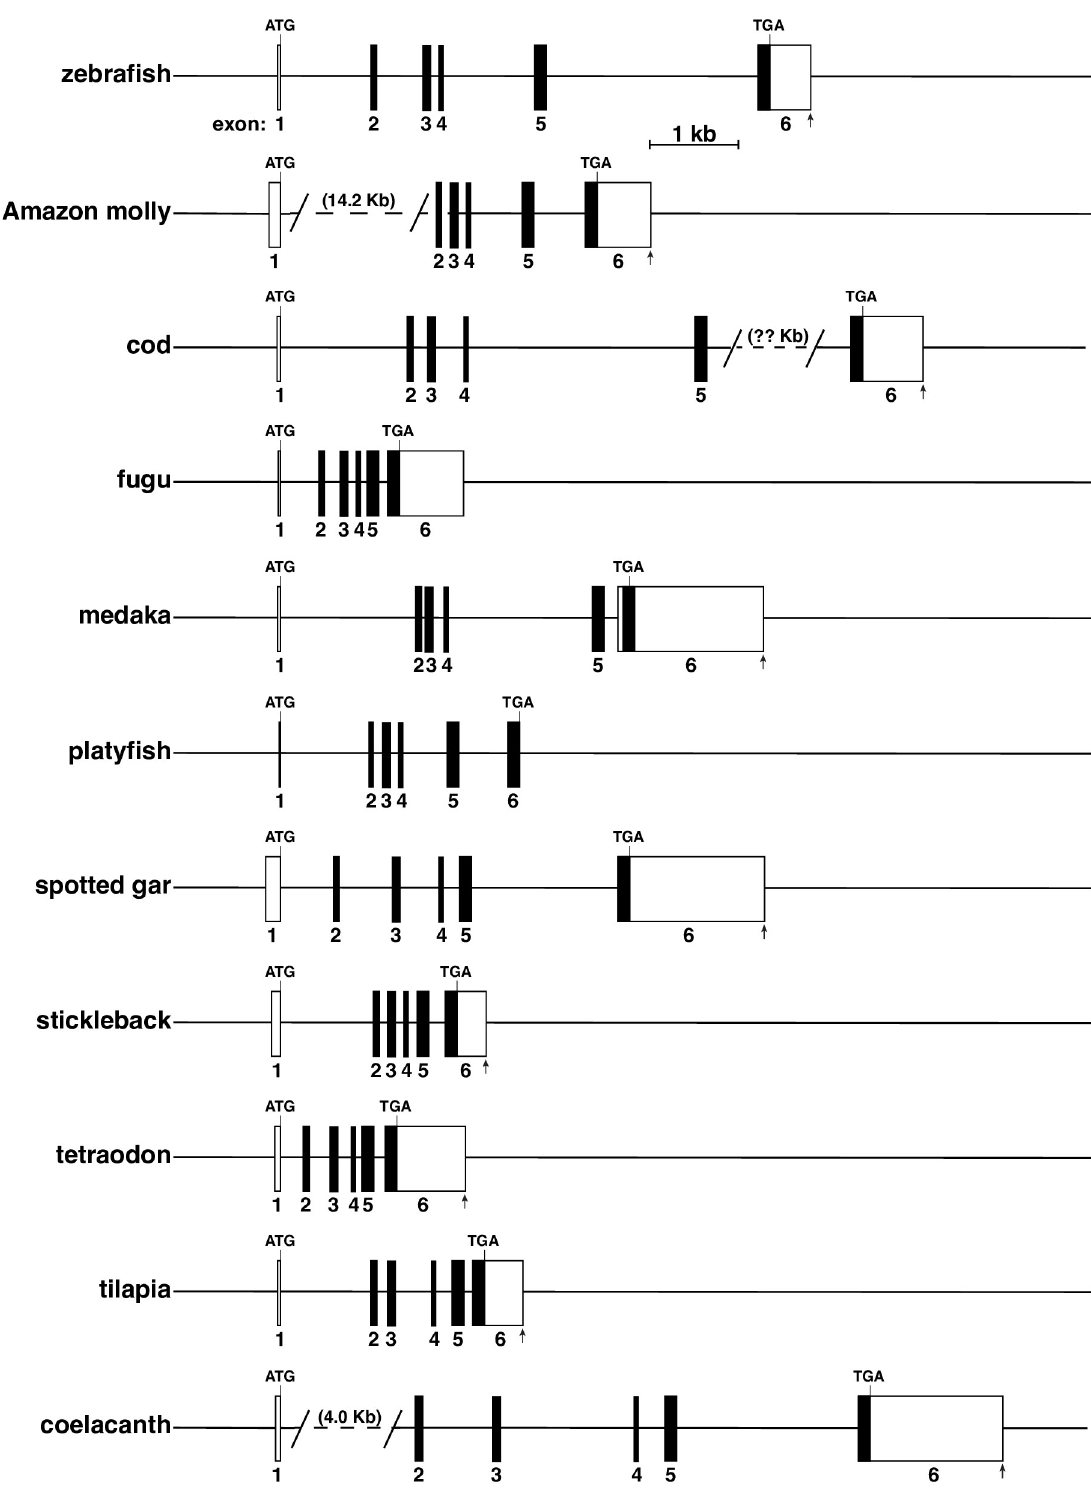
Fig 7. The Zmat2 gene in fish. Diagrams of zebrafish, Amazon molly, cod, fugu, medaka, platyfish, spotted gar, stickleback, tetraodon, tilapia, and coelacanth Zmat2 genes. Exons are indicated as boxes, with coding regions in black and non-coding segments in white for each gene. Locations of ATG and TGA codons are indicated, as is the putative 3’ end of exon 6 for each gene (vertical arrow). A scale bar is shown. See Tables 6 and 7 for more details.